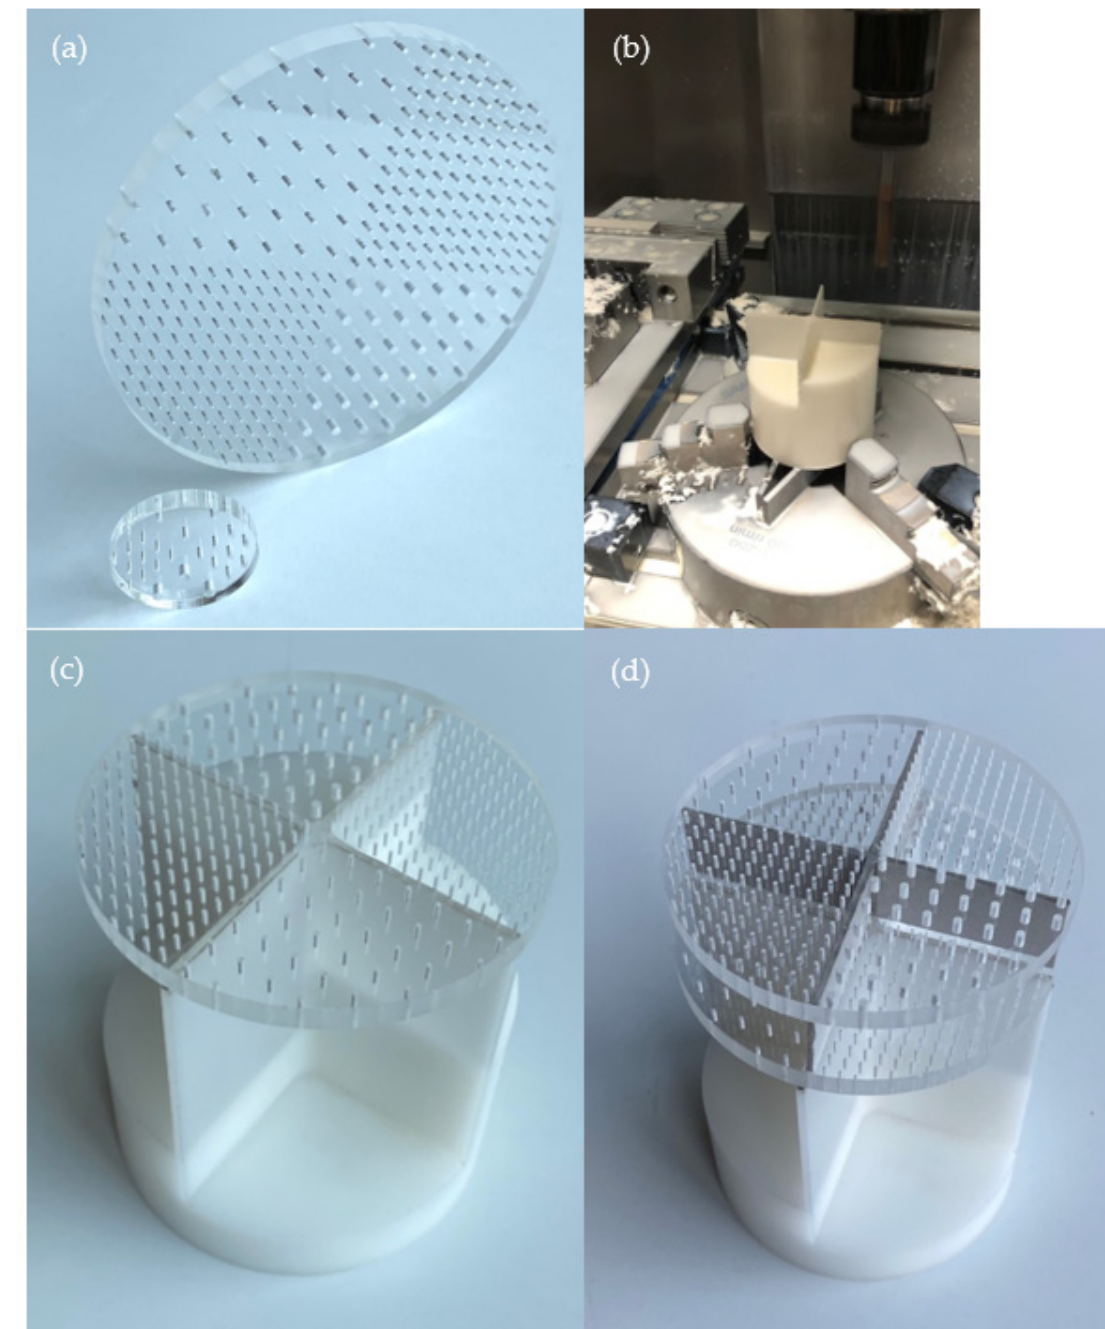
Figure 4. ( a ) Acrylic prototypes; ( b ) CNC machining tools etching the back cavity structure; ( c ) Prototype 1—One-layer parallel-arranged MPPs; ( d ) Prototype 2—Double-layer parallel-arranged MPPs.